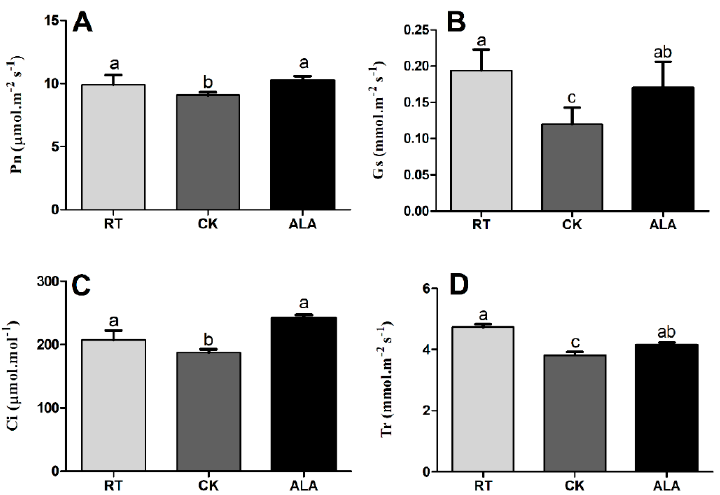
Figure 2. The effect of ALA on photosynthetic parameters ( Pn ; net photosynthesis ( A ), Gs ; stomatal conductance ( B ), Ci ; intercellular CO 2 concentration ( C ), and Tr ; transpiration rate ( D )) under low-temperature stress. RT = regular temperature; CK = control; ALA = 30 mg/L ALA. Different letters indicate a significant difference at p < 0.05.